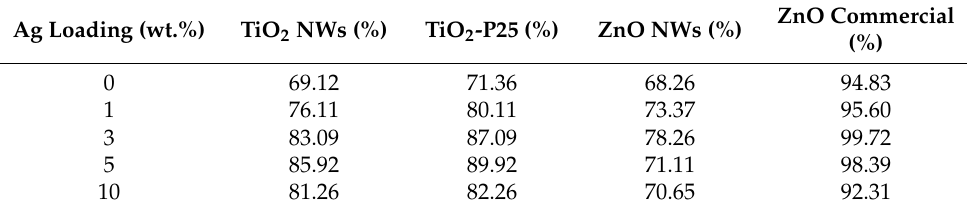
Table 6. Degradation percentages of all silver-based catalysts after 60 min of reaction.